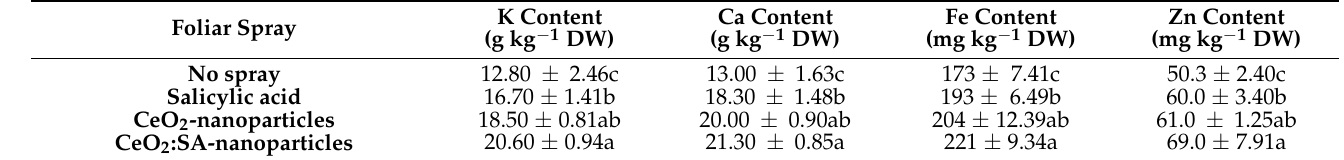
Table 10. Comparison of means for the effects of foliar applications (no spray, salicylic acid, CeO 2 - nanoparticles, and CeO 2 :SA-nanoparticles) on K, Ca, Fe, and Zn content in Portulaca oleracea plants. Foliar Spray